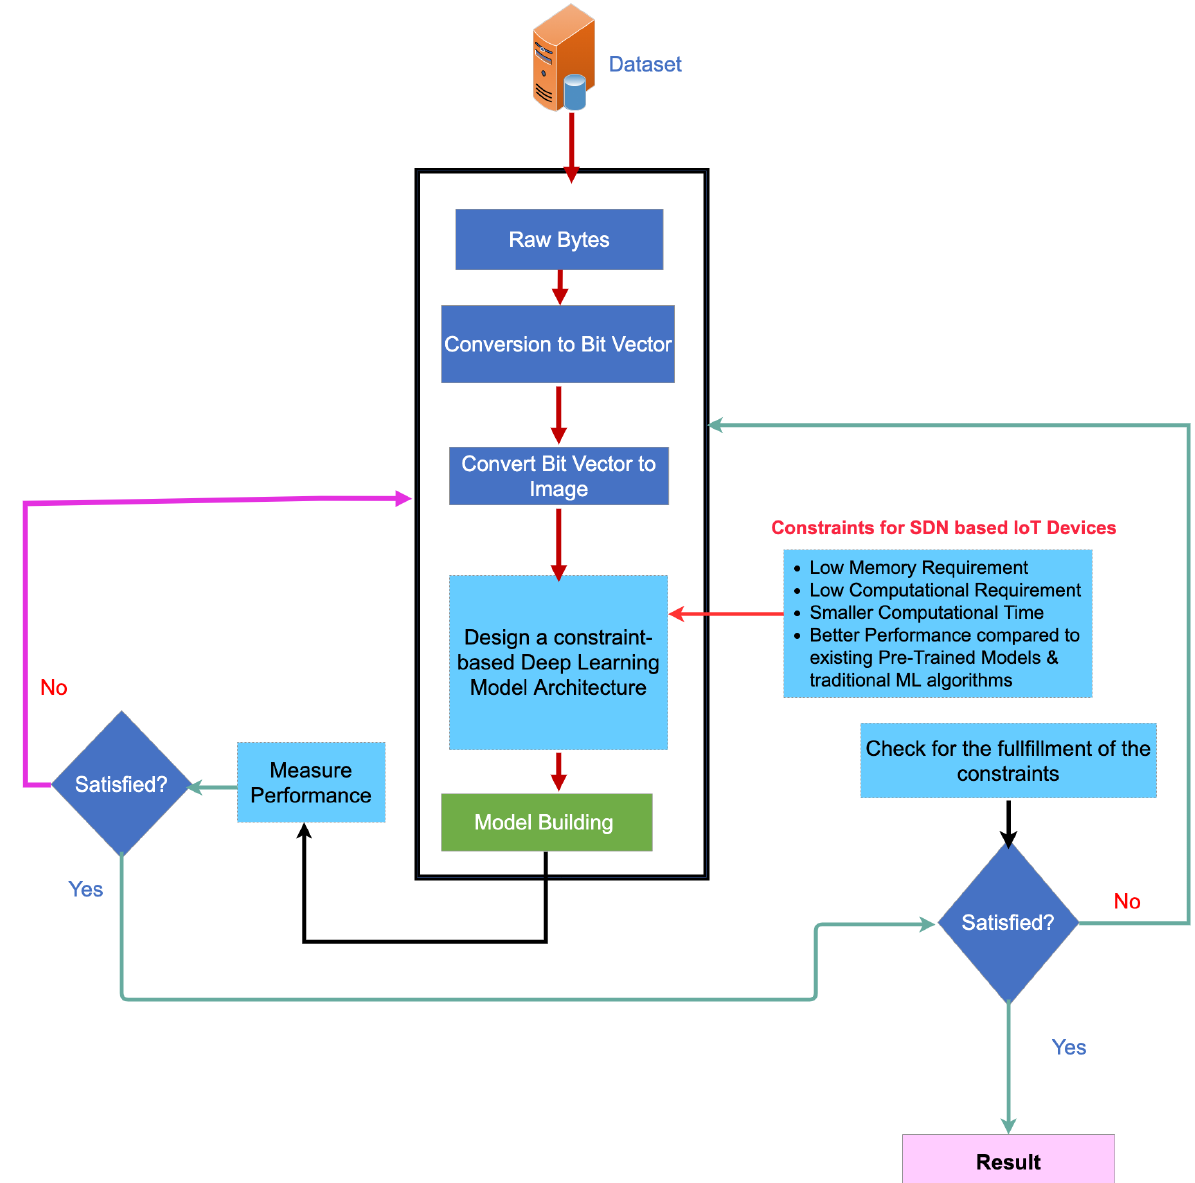
Figure 1. Proposed lightweight model architecture for SDN-IoT orchestrated botnet